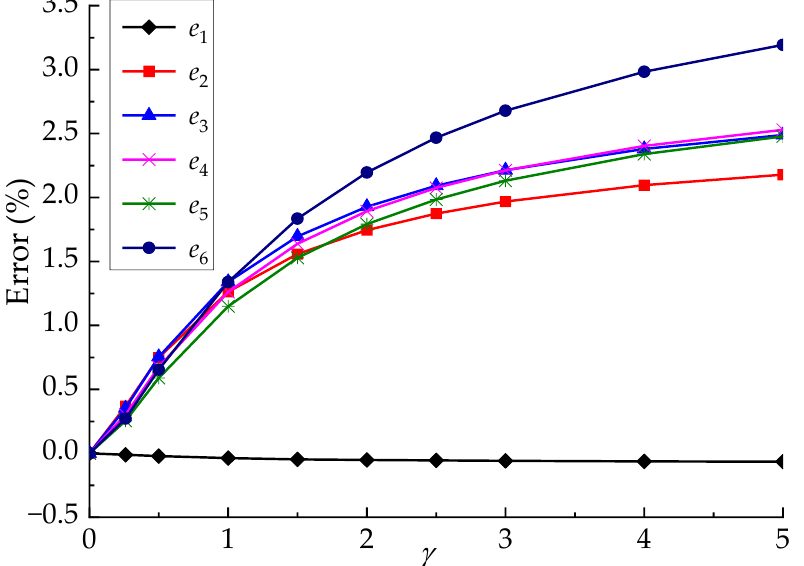
Figure 2. The percentage errors of the first six natural frequencies of the NAVMI factor solutions with respect to the Galerkin solutions for an entirely submerged ( µ = 1.0) elliptical cylinder ( b 0 / a 0 = 0.5), as the function of the cylinder–water density factor γ .